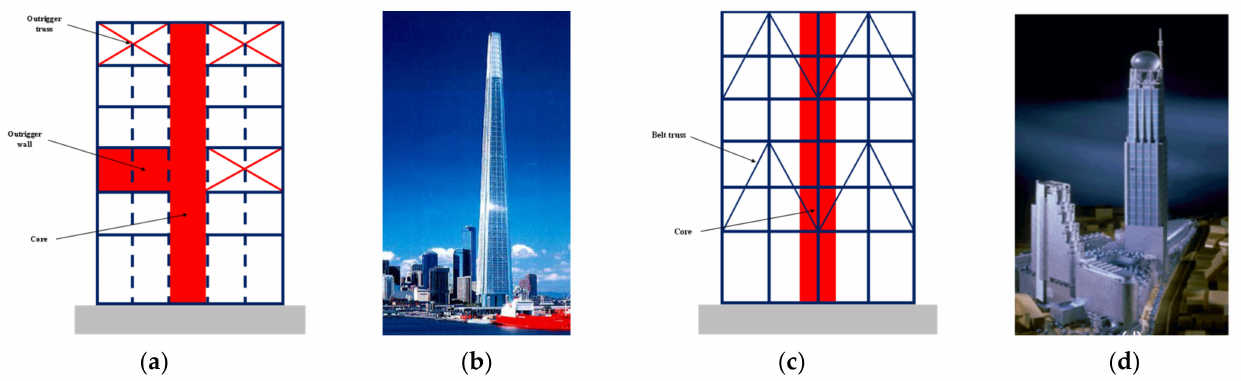
Figure 12. ( a ) Illustration of outrigger system; ( b ) Melbourne Tower; ( c ) illustration of “virtual outrigger” system using belt trusses; ( d ) Plaza Rakyat tower